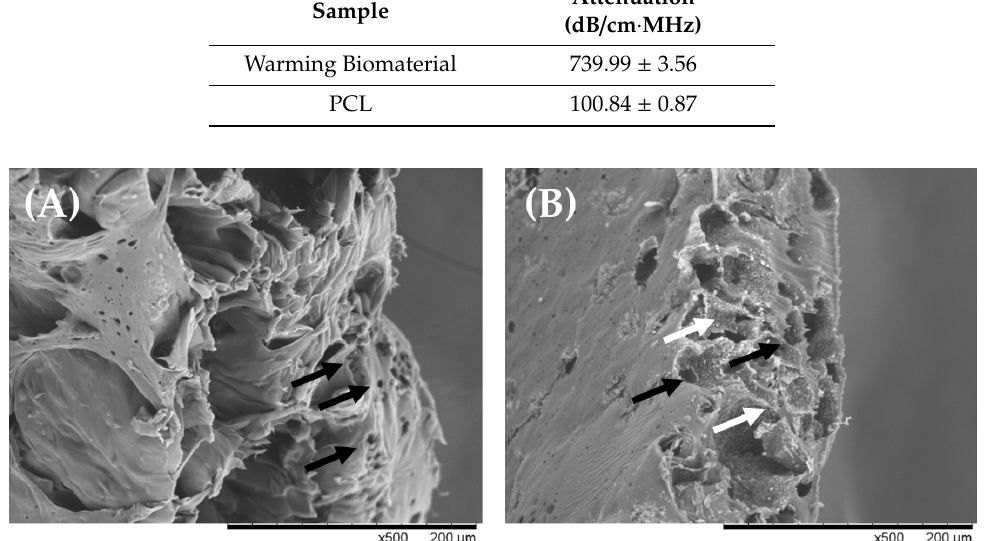
Figure 1. Morphology of biomaterials longitudinal sections by scanning electron microscope. ( A ) PCL membrane, and ( B ) warming biomaterial. White arrows indicate magnetic nanoparticles and black arrows indicate pores of biomaterials.